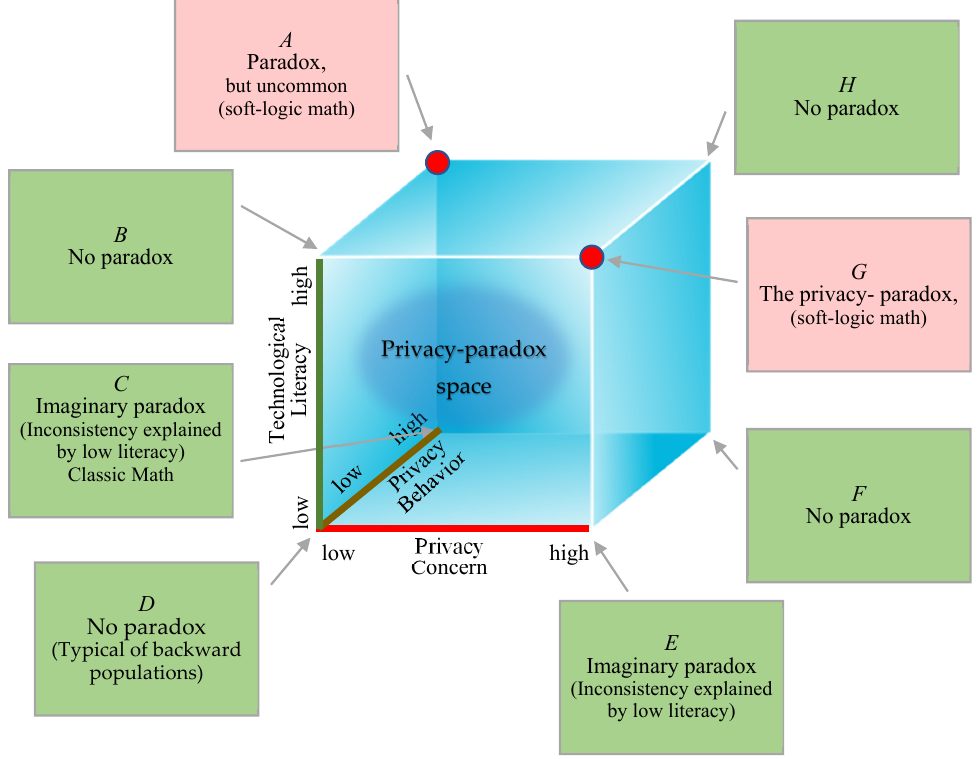
Figure 2. Three-dimensional model of the privacy